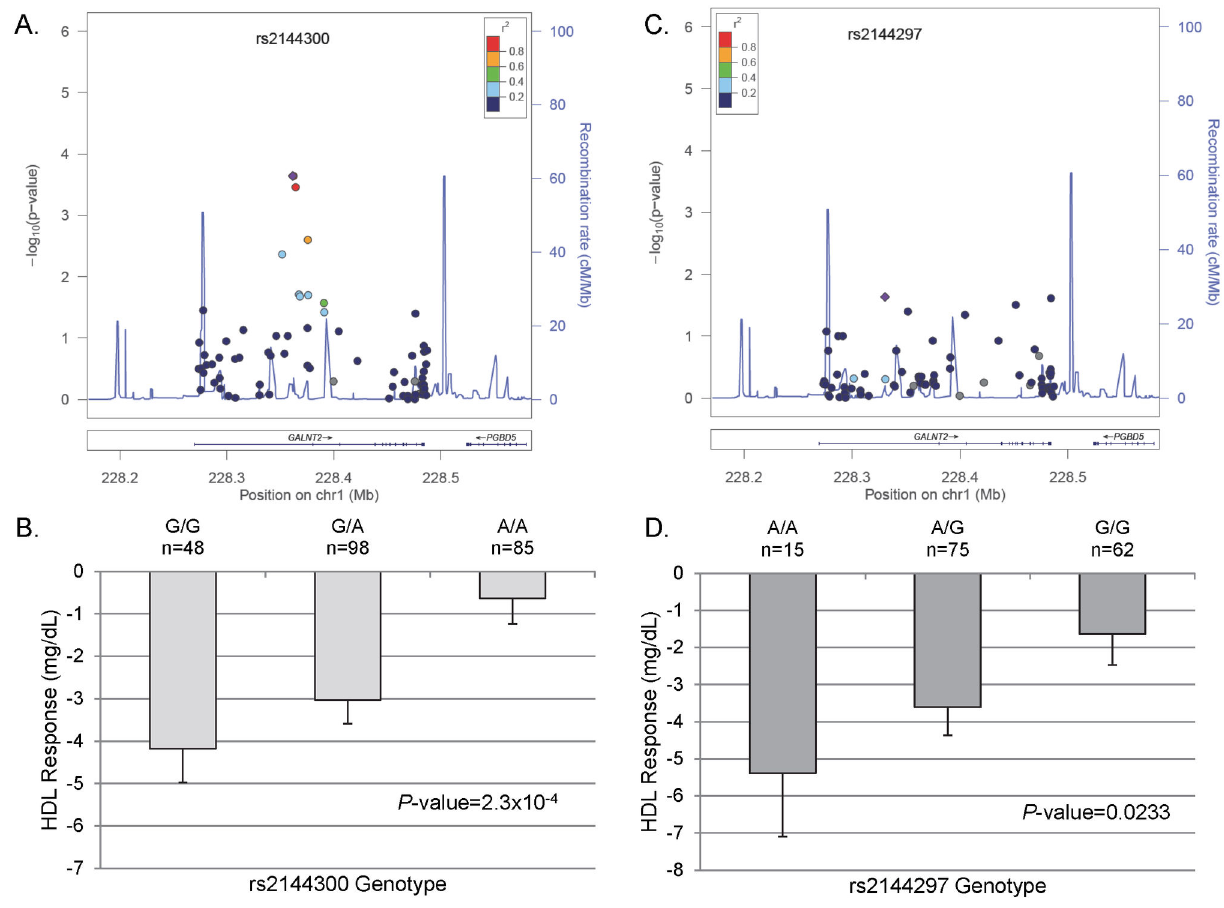
Figure 1. GALNT2 Regional Plots and adjusted HDL-C response by genotype. (A) Regional Plot in PEAR whites. (B) HDL-C response in PEAR whites by rs2144300 genotype. (C) Regional Plot in PEAR African Americans. (D) HDL-C response in PEAR African Americans by rs2144297 genotype. Error bars represent standard error. doi: